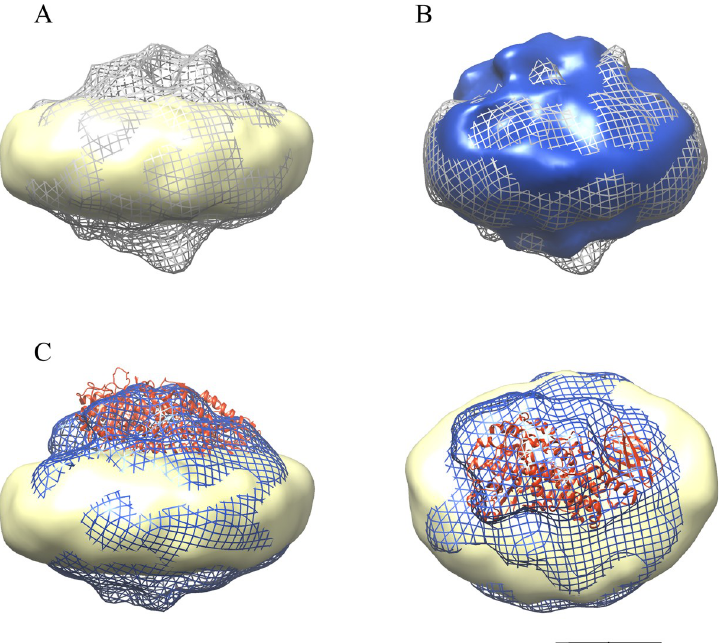
Fig 6. 3D-reconstructions of NaPT-stained particle sets. A) Complex 5LOFNDAA (grey mesh) and FND (yellow). B) Complexes 5LOFNDCa (blue) and 5LOFNDAA (grey mesh) show similar densities. C) Side and top views of the complex 5LOFNDCa (blue mesh) and FND (yellow). The atomic structure of 5LO (PDB ID:3O8Y, red ribbon) was manually docked to the map. Scale bar 5 nm.